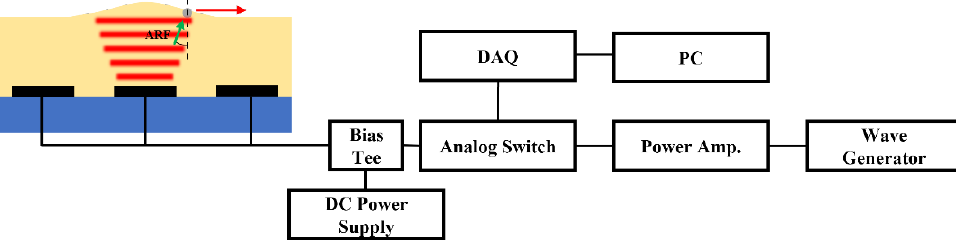
Figure 1. Schematic of particle manipulation principle and system. The acoustic radiation force is determined by the pressure field of the transducer. Each element of the CMUT used in this study is an 800 um square transducer with a center frequency of 2 MHz. The 3 dB angle of divergence of each element is 16 degrees, and the pitch between elements is 1 mm. For particle movement with this transducer array,